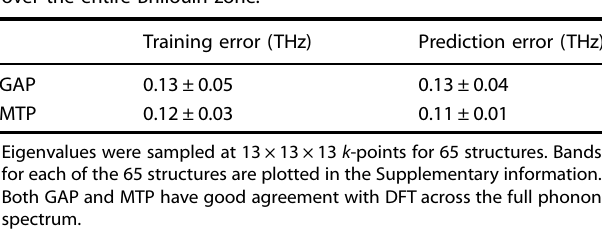
Table 6. Mean RMSE for phonon predictions when integrating errors over the entire Brillouin zone.